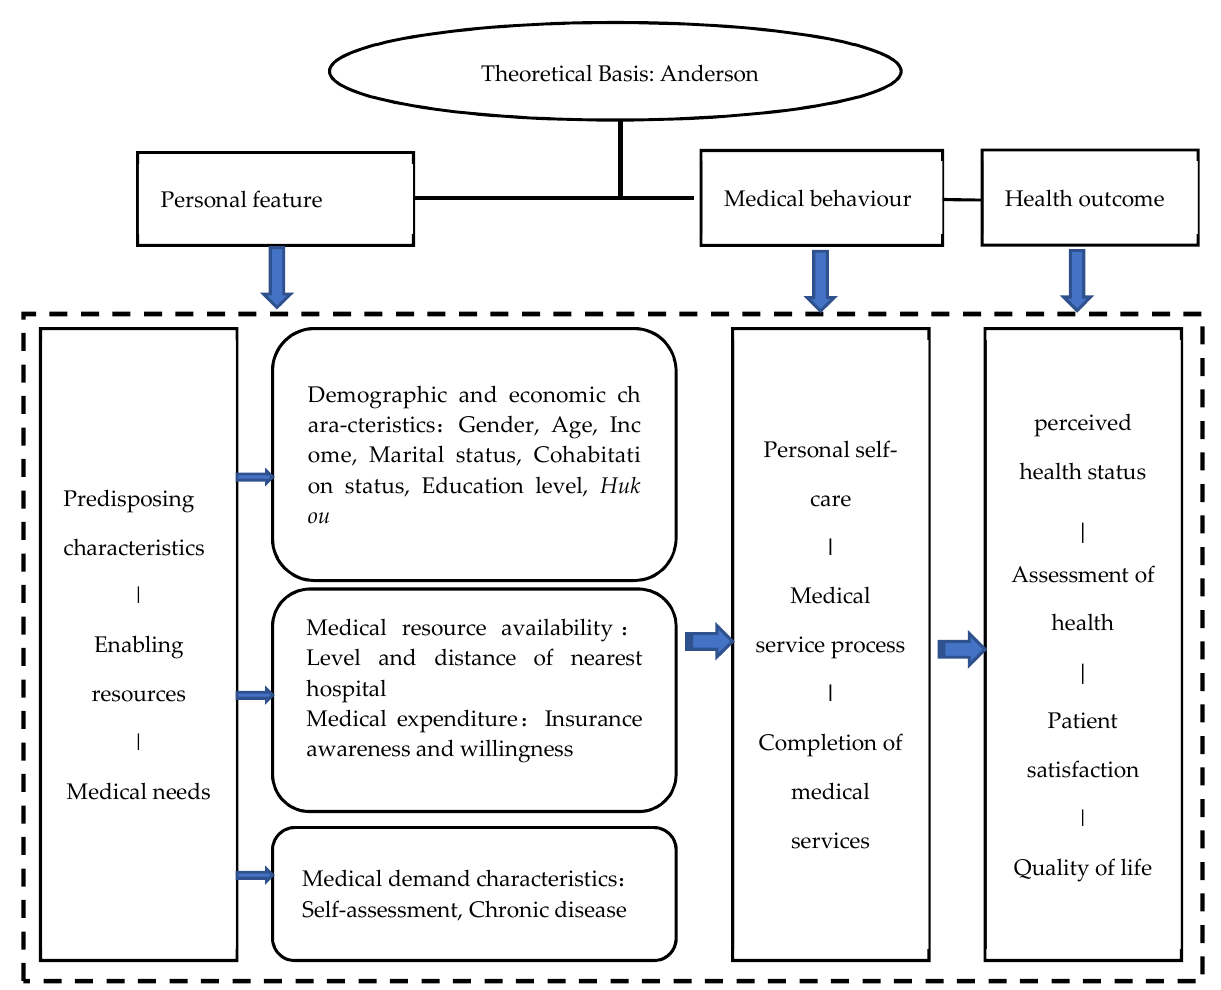
Figure 1. Theory of Medical Behaviour of Elderly People in Shanghai (in the Anderson model, the indicators under the “contextual characteristics” dimension are all based on “community/society” as the analysis unit, which is not applicable to this study, so it is omitted in Figure 1).